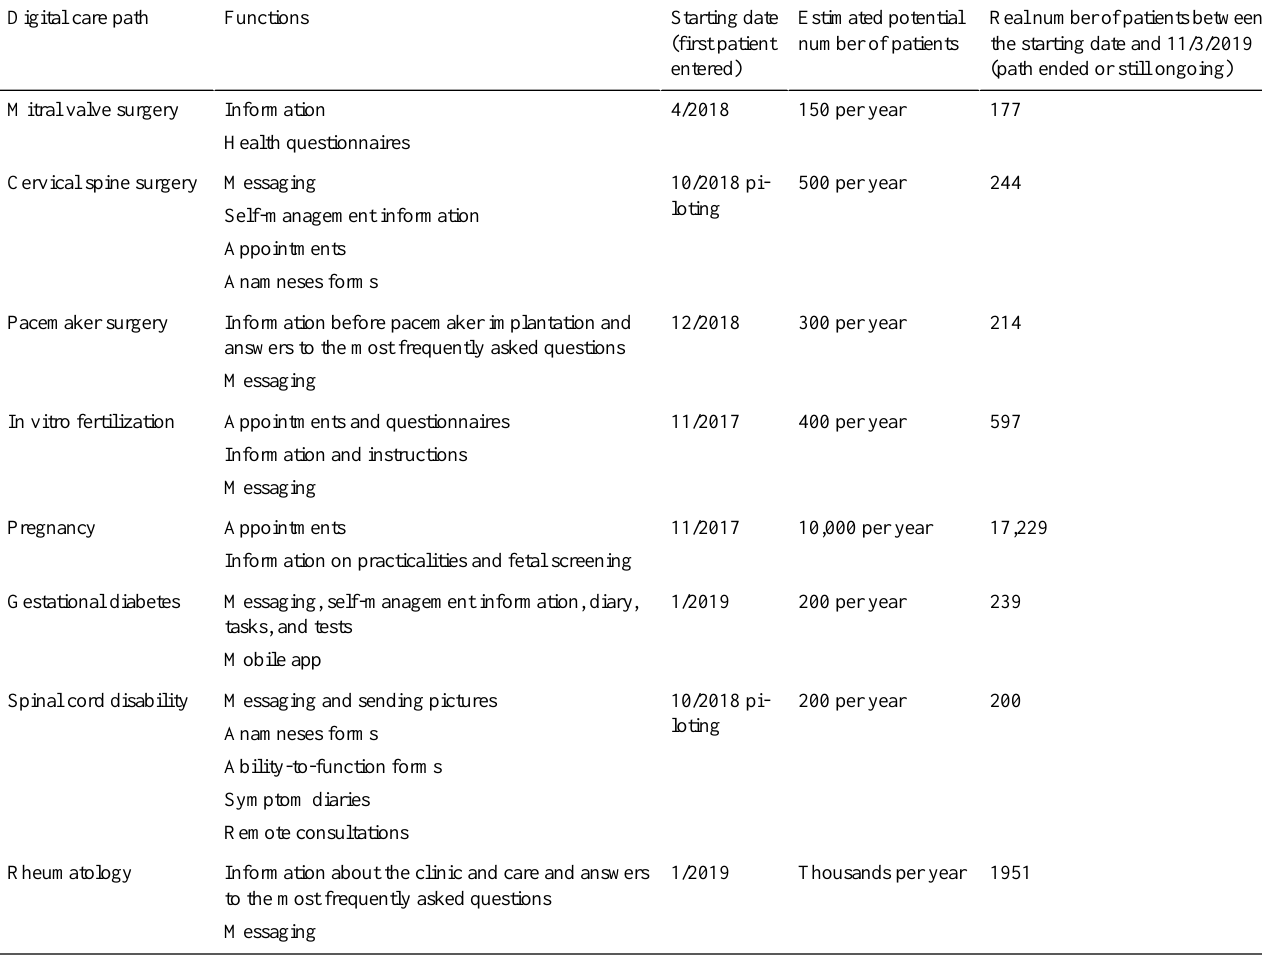
Table 1. Description of digital care